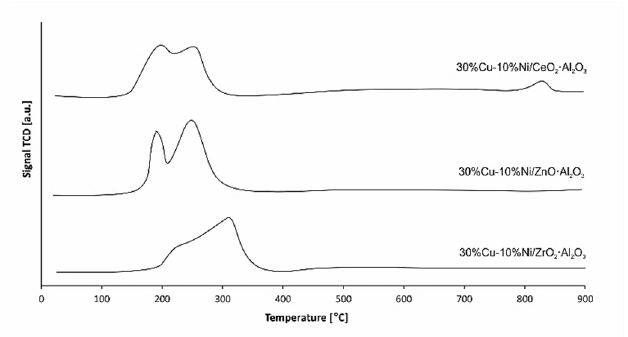
Figure 6. Temperature programmed reduction curves of calcined 30% Cu - 10% Ni bimetallic catalysts supported on ZrO 2 ·Al 2 O 3 , ZnO·Al 2 O 3 and CeO 2 ·Al 2 O 3 (400 °C for 4 h in an air atmosphere).